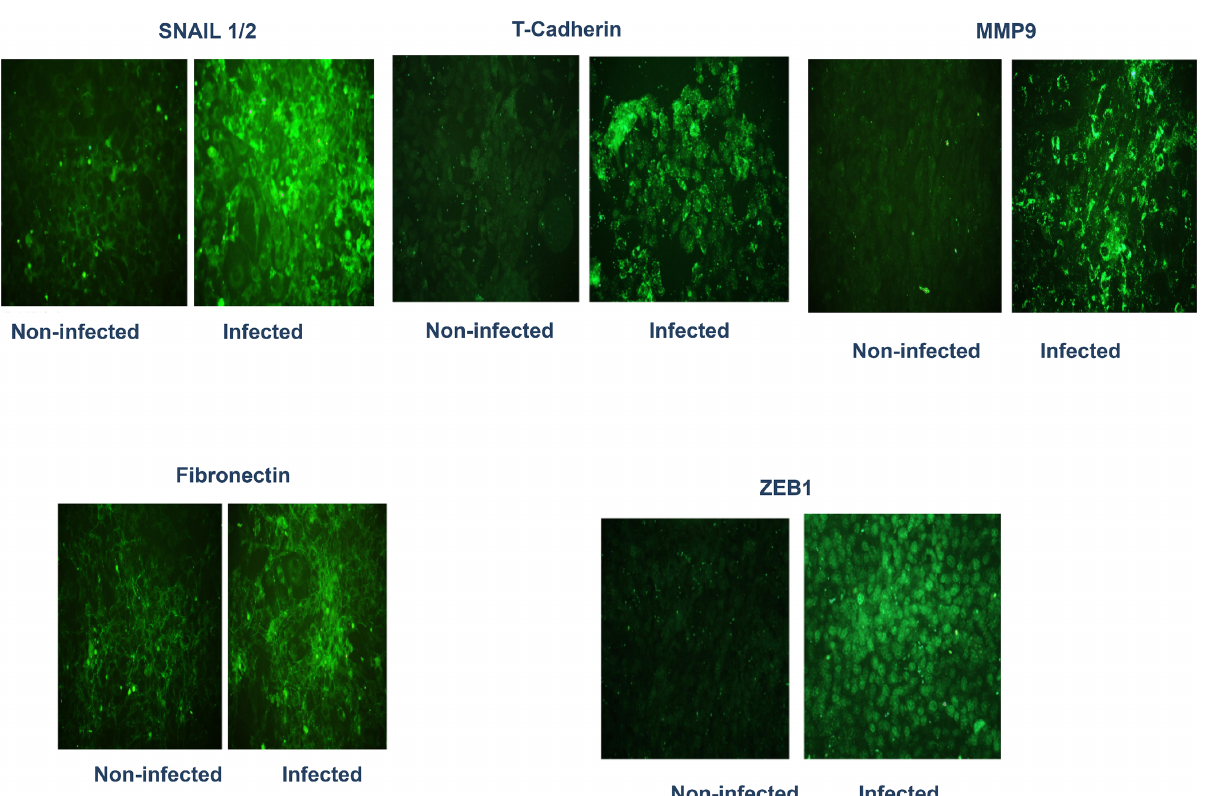
Fig 4. Chlamydia infection of reproductive epithelial cells induces epithelial-mesenchyme transition (EMT) (mesenchymal markers). Monolayers of murine oviduct epithelial cells were infected with C . trachomatis L and after 72h immunofluorescence staining of the cells for EMT markers was performed on infected and non-infected monolayers by standard procedures. Fluoresceinated antibodies against the following markers were used: T-cadherin, Snail1/2, fibronection, Zeb1 and MMP9. Antibodies stained both intracellular and surface antigens. Images were acquired at 20X objective on a Nikon fluorescent microscope with the same microscope settings and exposure time. The representative slides are from several repeated experiments showing identical